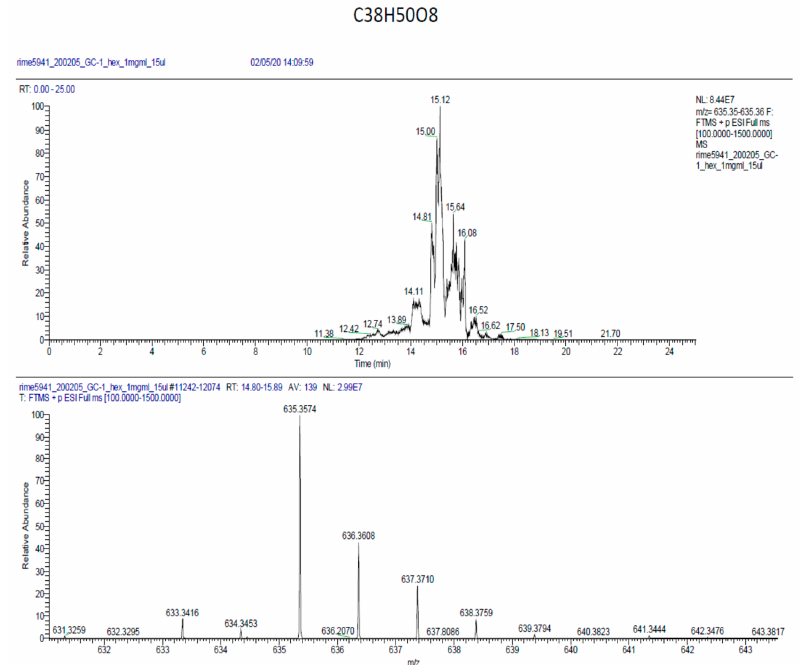
Figure A5. UPLC-MS analysis of the n -hexane extract of G. cambogia indicating the presence of desoxygambogenin.